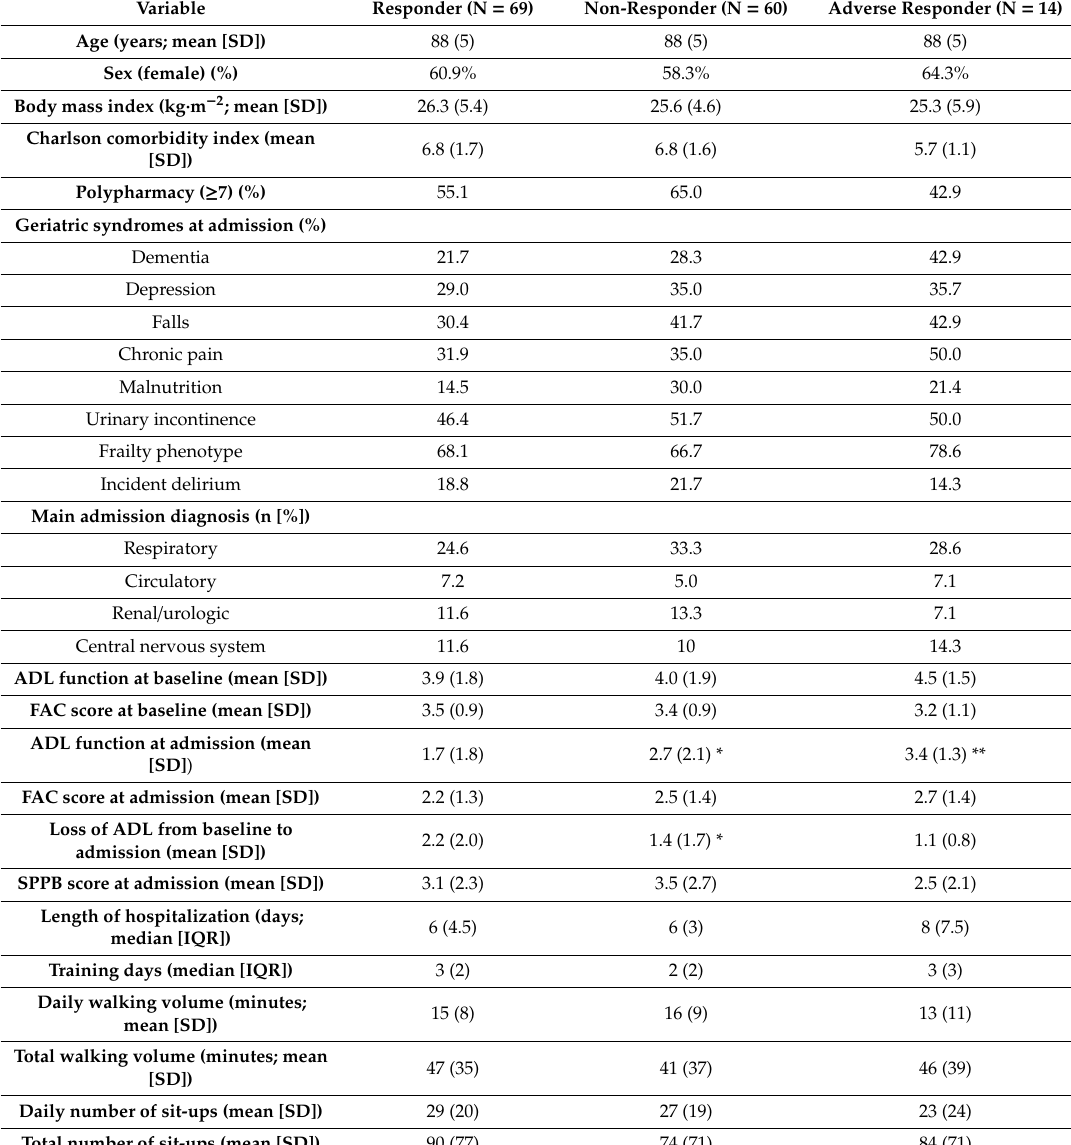
Table 1. Main characteristics of responders, non-responders or adverse responders to the exercise intervention attending to the change (i.e., improvement, no change or decrease, respectively) in functional ability (i.e., ability to perform activities of daily living [ADLs] independently) during hospitalization. Variable Responder (N = 69) Non-Responder (N = 60) Adverse Responder (N = 14) 88 (5) 88 (5) 88 (5) 60.9% 58.3%